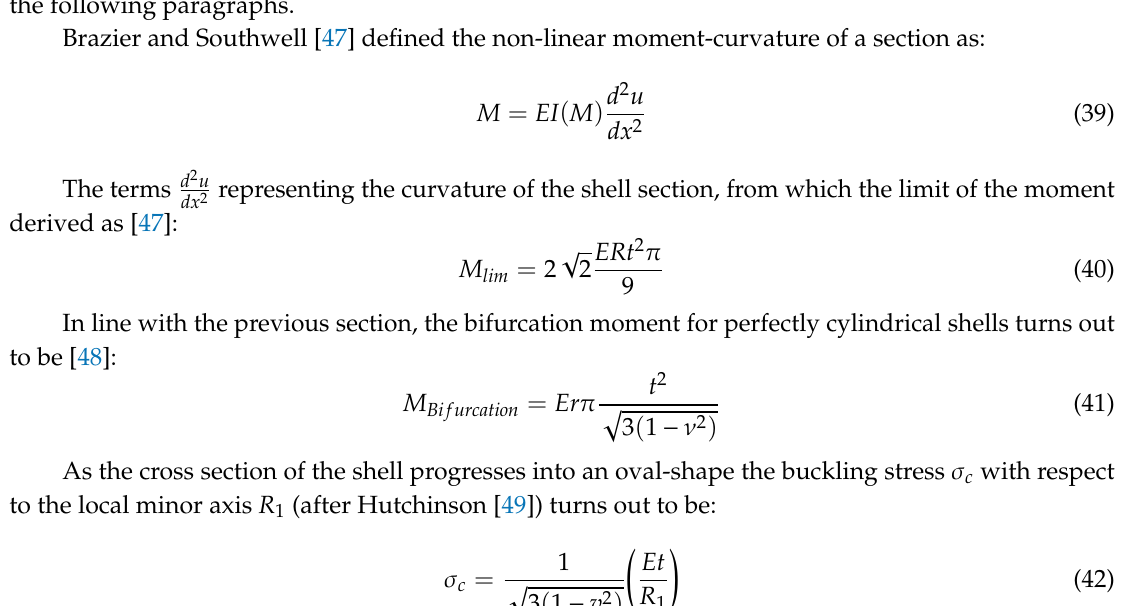
Figure 6. ( a ) Section ovalisation of a bending cylindrical shell; ( b ) the resulted effect of combined loads; and ( c ) the strip of a highly stressed shell segment.